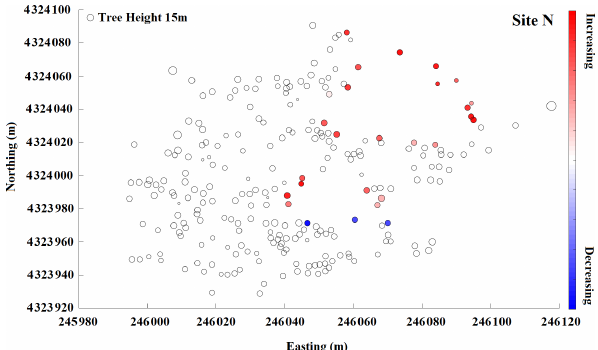
Figure B8. Snow depth change within a 10m buffer from the edge of a tree at site N. Red color indicates snow depth increases moving from the tree edge toward the open areas, and blue indicates snow depth decreases. Increasing and decreasing patterns are shown for individual trees at each site with adequate snow